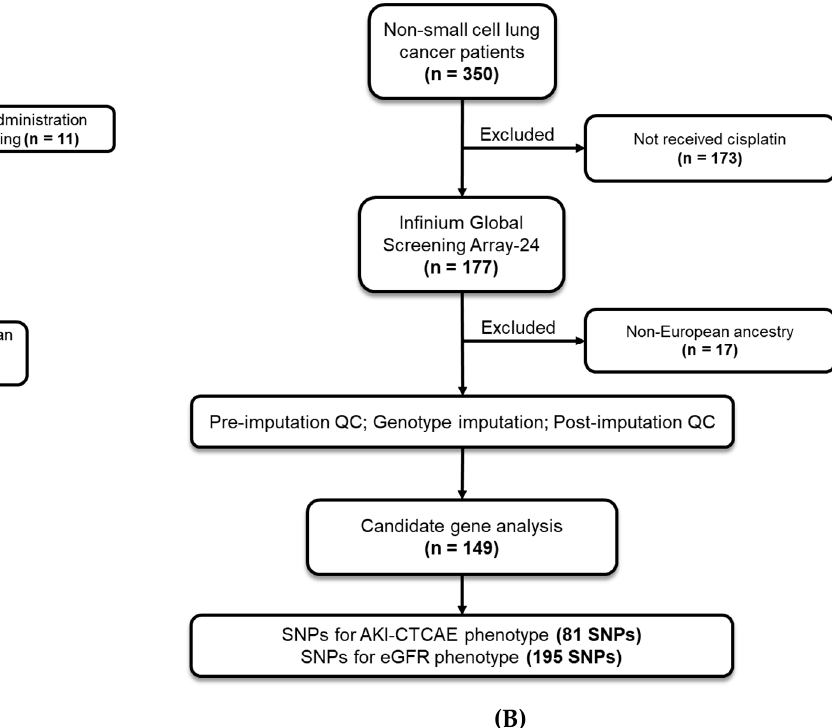
Figure 1. Flowchart of this study. ( A ) Discovery cohort ( n = 608). The discovery cohort consisted of head and neck cancer patients ( n = 555) and esophageal cancer patients ( n = 167). Three arrays were used for genotyping. After pre ‐ imputation QC, imputation and post ‐ imputation QC, data of 608 patients in total were included for analysis. ( B ) Validation cohort ( n = 149). The validation cohort consisted of non ‐ small ‐ cell lung cancer patients ( n = 350). After pre ‐ imputation QC, imputation, post ‐ imputation QC and exclusion for chemotherapeutic therapy, 149 patients in total were included for analysis. Abbreviations: AKI ‐ CTCAE (Common Terminology Criteria for Adverse Events v4.03 for acute kidney injury), GWA (genome ‐ wide association), SNPs (single ‐ nucleotide polymorphisms), and QC (quality control).